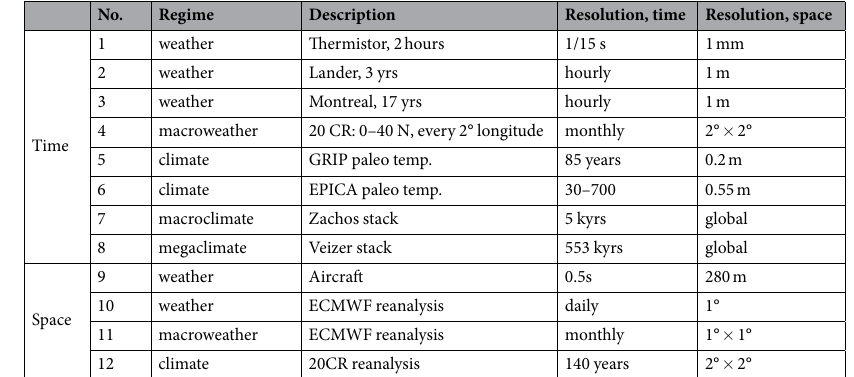
Table 1. A summary of the data used in this study, see Methods for more